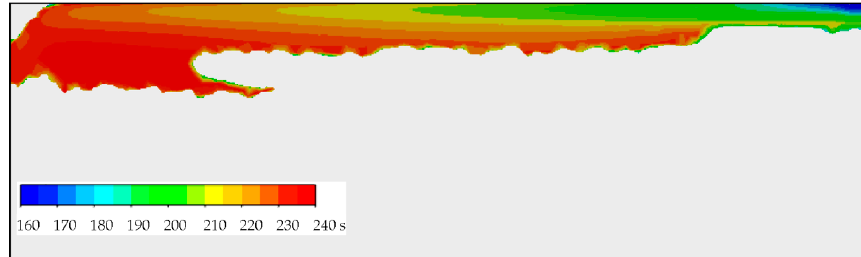
Figure 14. Map of activation times for experiment #03 (after 250 s of simulation).